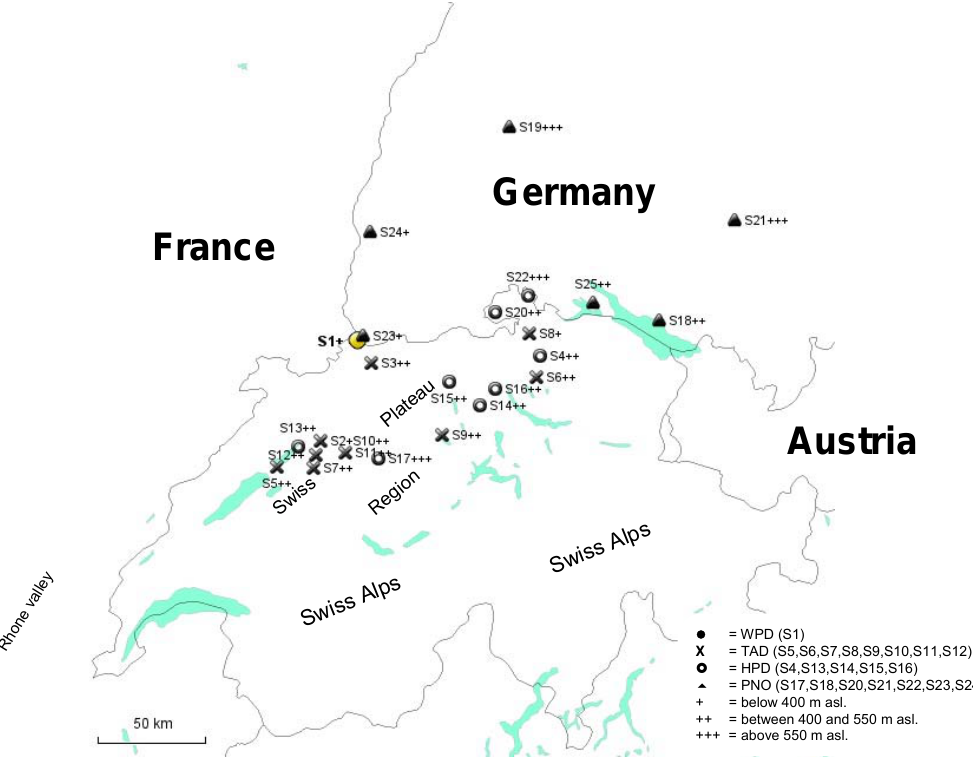
Fig. 1. Location of WPD-, TAD-, HPD- and PNO series in northern Switzerland and south western Germany.